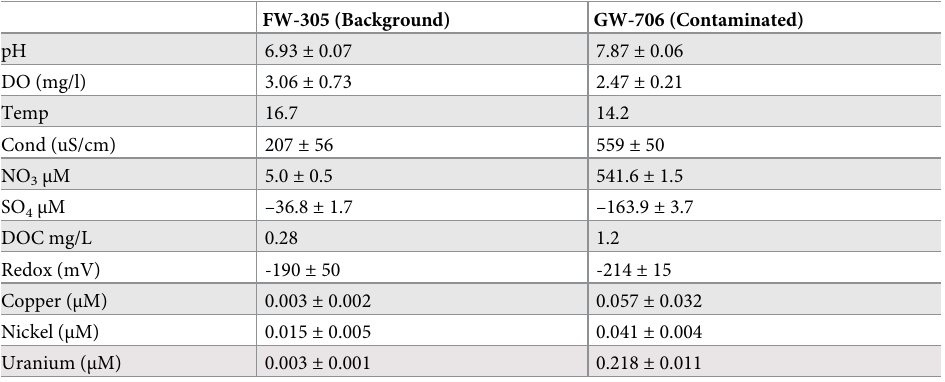
Table 1. Comparison of groundwater well geochemistry as measured